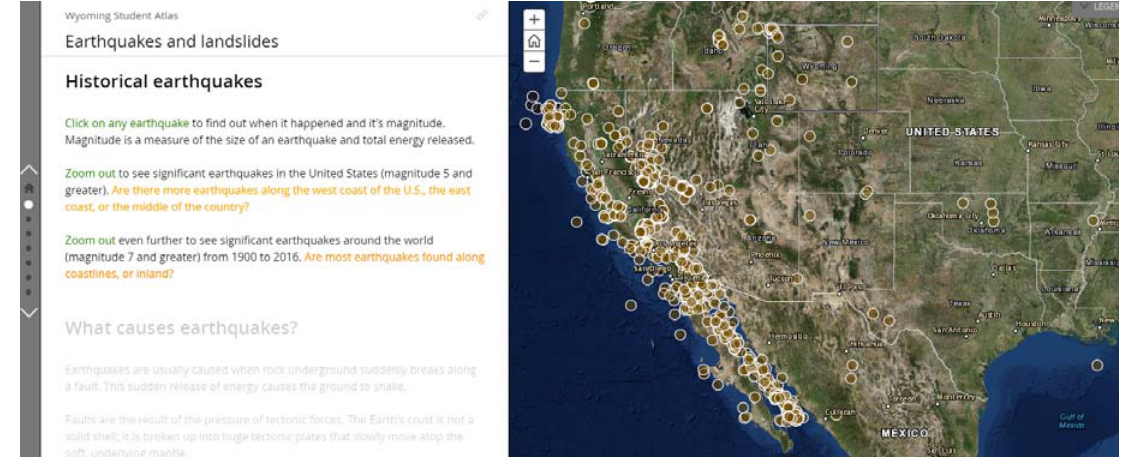
Figure 3. Screenshot of a page from an atlas story map prompting students to explore a theme at a national or even global scale after first seeing a local or regional pattern.